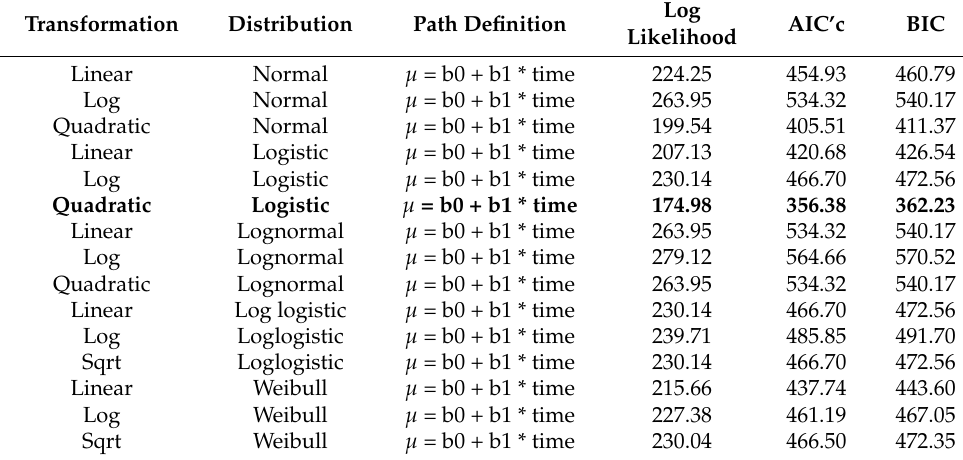
Table 4. Tensile model